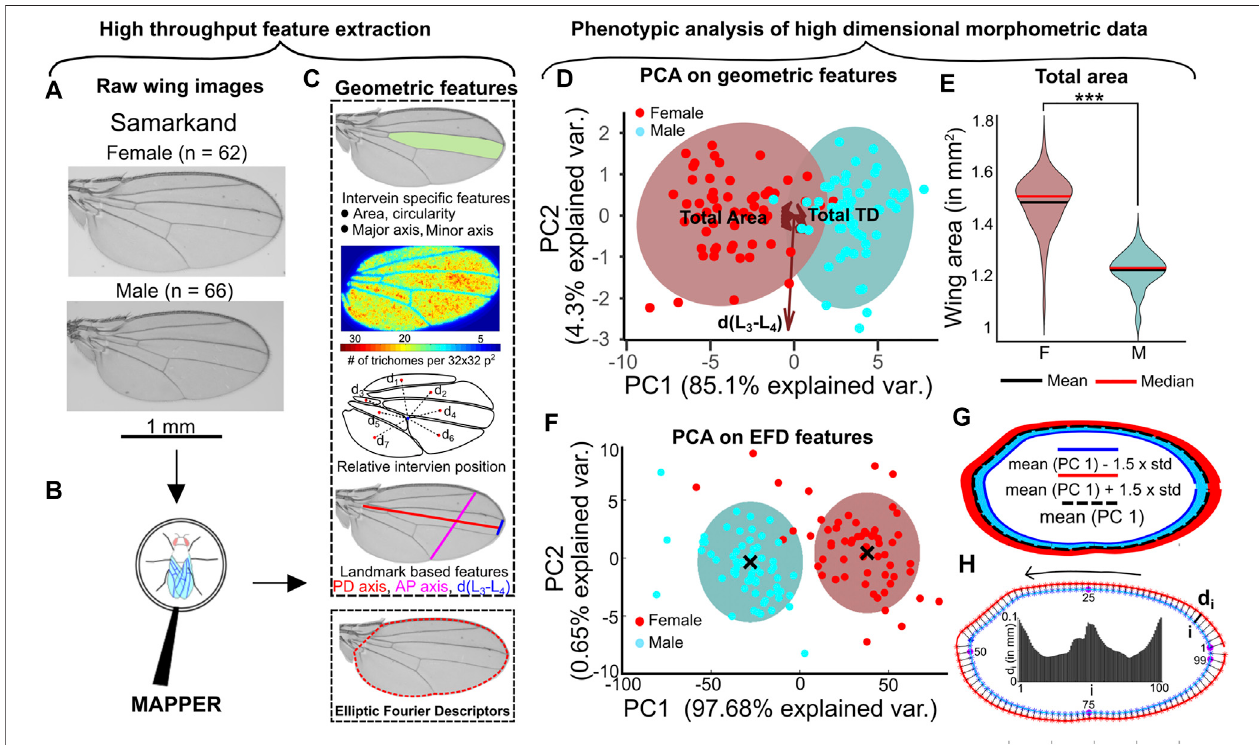
FIGURE 5 | Representative statistical approaches for phenotypic analysis. (A) Male and female Samarkand wings (Sonnenschein et al., 2015), with sample sizes indicated, were analyzed and processed (B) to demonstrate MAPPER ’ s phenotypic pro fi ling features. (C) De fi nition of the wide number of geometric/morphological features including extracted EFD coef fi cients fi t to the wing margin. (D) PCA reveals the largest variance in the data observed in terms of overall wing area and trichome density. As expected, two distinct clusters are evident when plotting the fi rst to PCs. (E) Violin plot showing the distribution of area of male and female wings. Solid redlineindicatesthemedianandsolidblacklineindicatesthemeanofeachpopulation. (F) PCAonEFDrevealedmostofthevarianceinthedataconcentratedonlyinthe fi rst principal component. Two distinct clusters separate the male and female populations. (G) Standard deviation in the direction of PC1 was calculated for the entire population of wings. PC1 was varied by adding and subtracting 1.5 times the standard deviation along PC1. Reverse PCA was then used to obtain the desired EFD coef fi cientsinwhichthecontourswerereconstructed. (H) EFDwasusedtoconstructmeanwingshapesrepresentingthemaleandfemalepopulations.100pointswere sampledfromthemalewingandtheirminimumdistancefromthefemalewingwascalculatedtoquantifylocalsizedifferenceswithinthetwopopulations.Thevariationof size is drawn as a bar graph where the x-axis is representative of the points sampled in male wing. The locations of points sampled are indicated in the